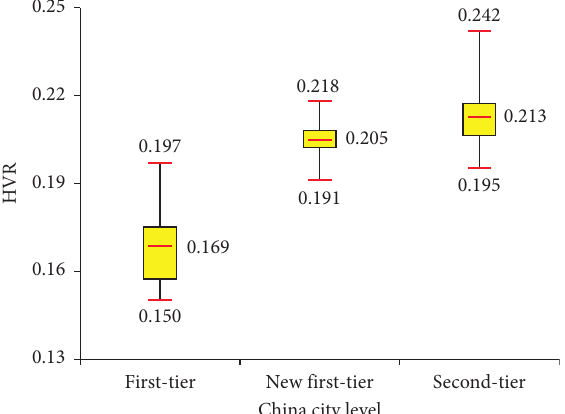
Figure 5: Boxplot of HVR in different cities.